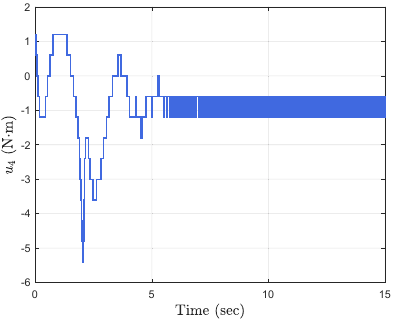
Figure 8. Event − triggered control input u 4